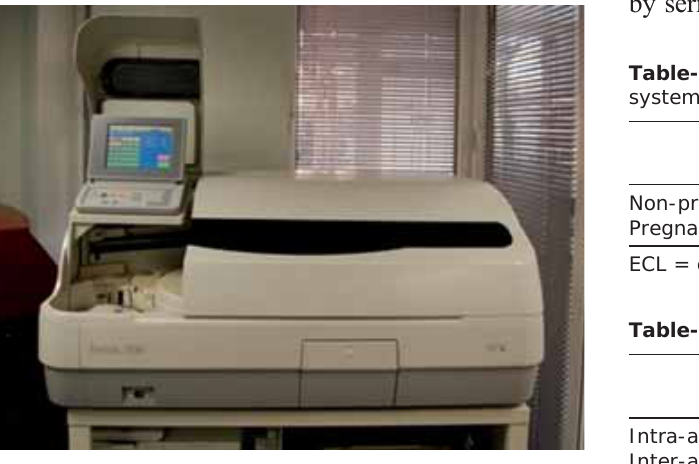
Figure-1: Photo represent measurement instrument (Elecsys 2010).